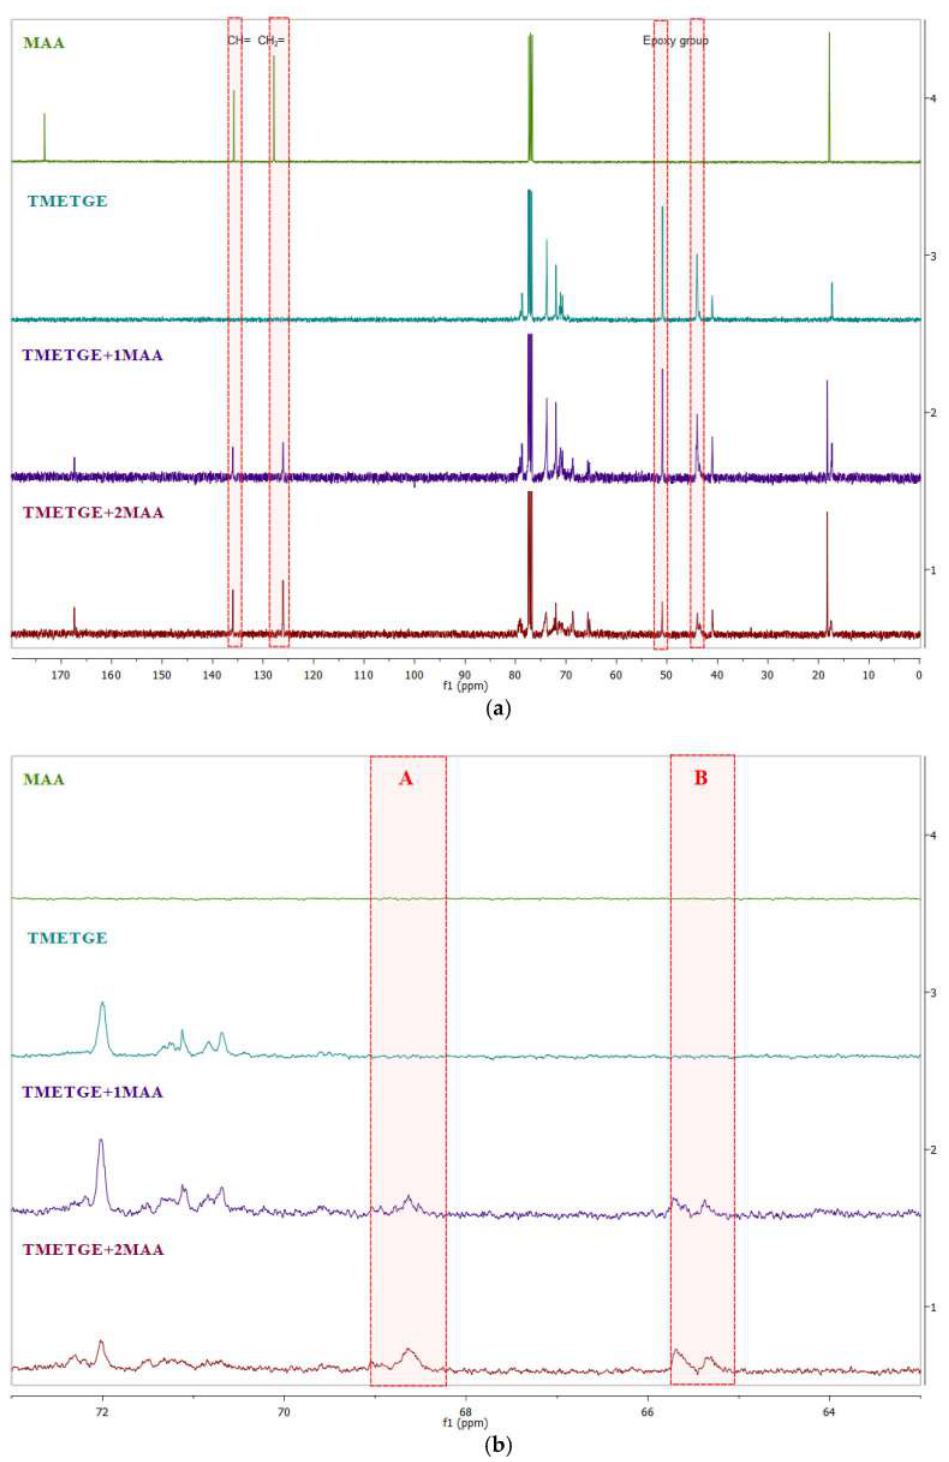
Figure 8. Fragments of the 13 C NMR spectra (CDCl 3 ) of ( a ) AA, triglycidyl ether of trimethylolethane, TMETGE + 1AA, and TMETGE + 2AA (from the top) and ( b ) MAA, triglycidyl ether of trimethylolethane, TMETGE + 1MAA, and TMETGE + 2MAA (from the